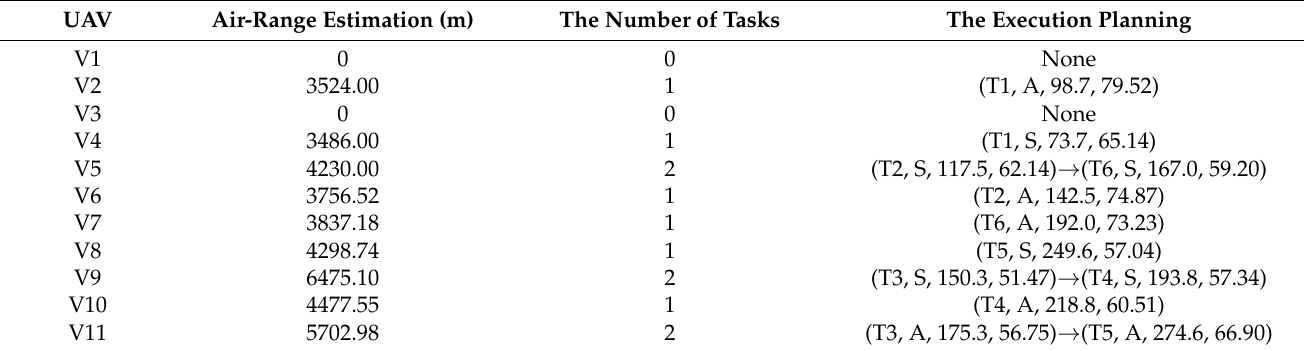
Table 5. The task assignment of the UAV swarm.